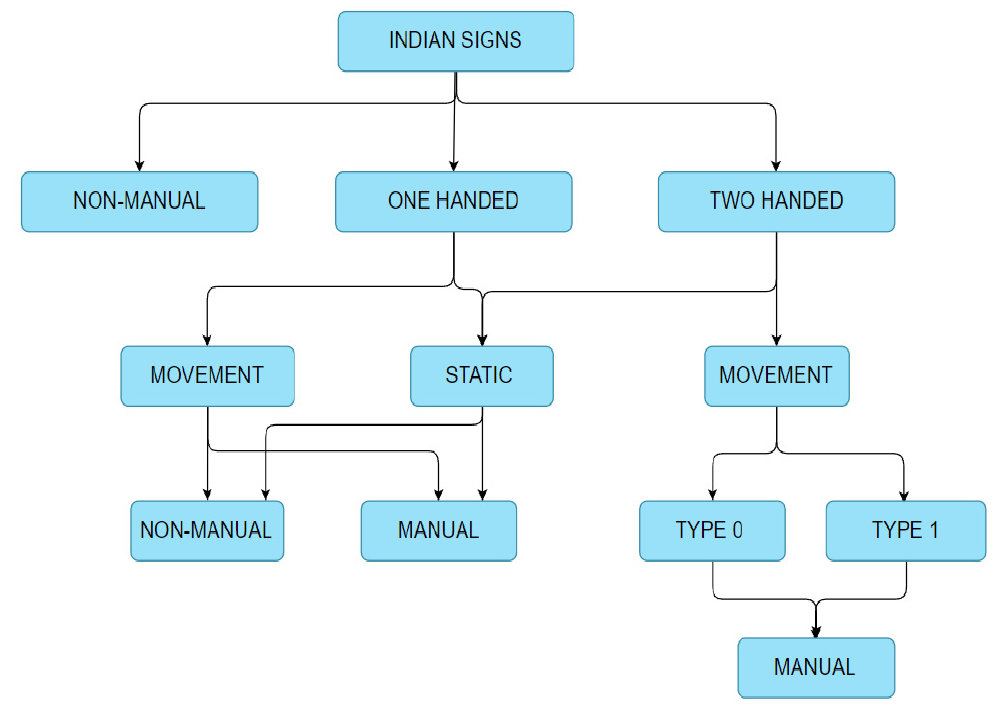
Figure 3. Types of Hand Gestures.